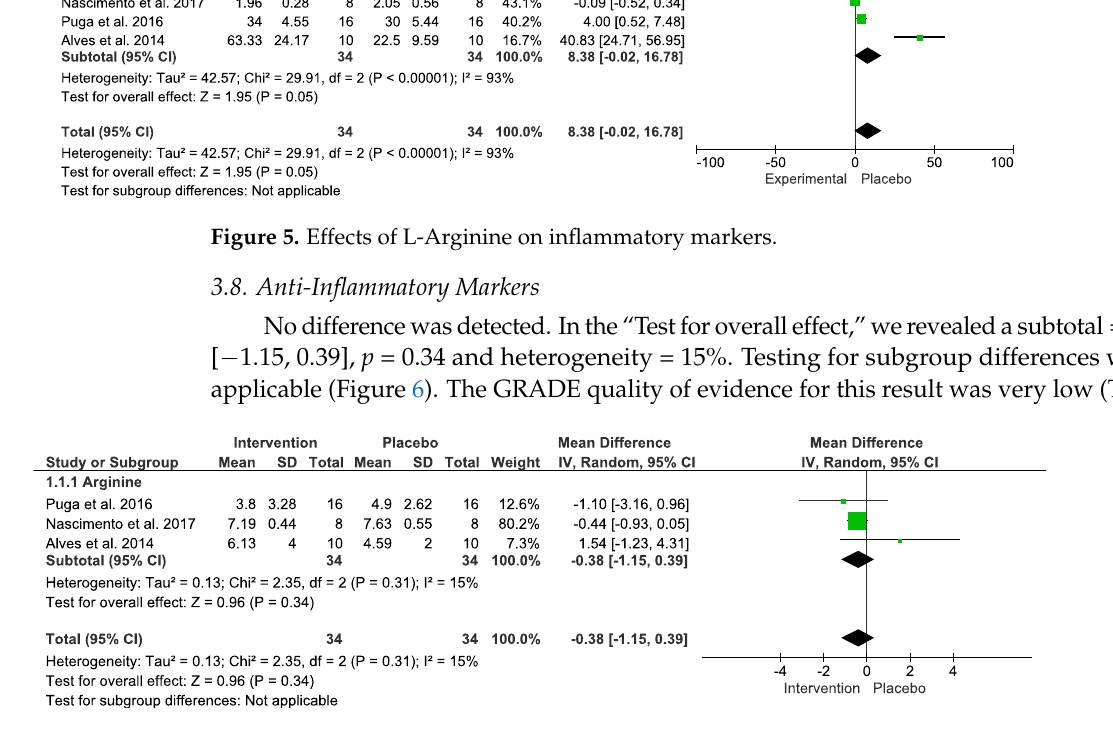
Figure 6. Effects of L-Arginine on anti-inflammatory markers .